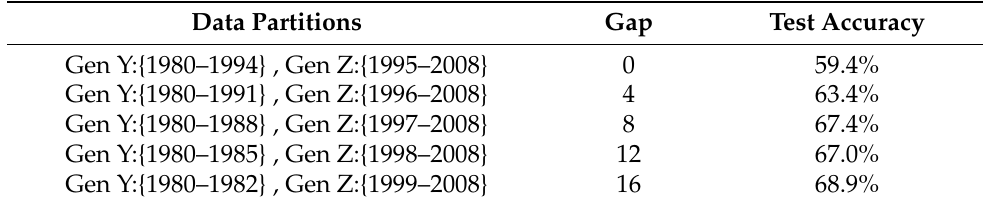
Table 10. Accuracy by age group considering different temporal gaps for the virtual human avatars classification task. The gaps are reported in